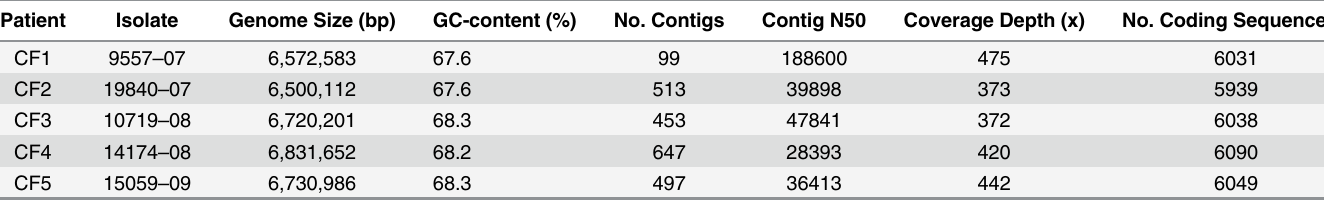
Table 2. General features of draft genomes of incipient